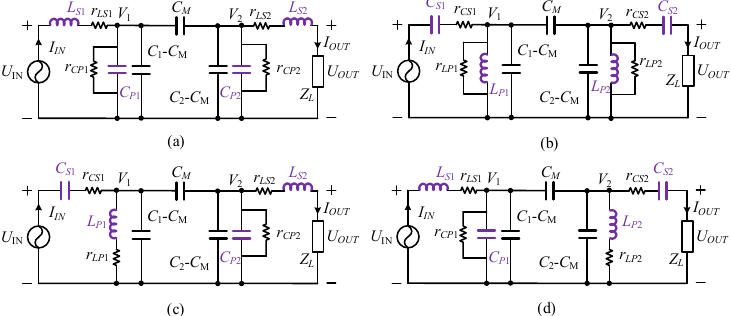
Figure 13. SP-based CPT topology considering the parasitic resistance. ( a ) Double-sided LC compensation, ( b ) double-sided CL compensation, ( c ) CL − LC compensation, ( d ) LC − CL compensation. The system efficiency of four SP-based compensation topologies can be derived from Equations (49) and (50). Taking the LCCL compensation topology as an example, its AC − AC efficiency is calculated as